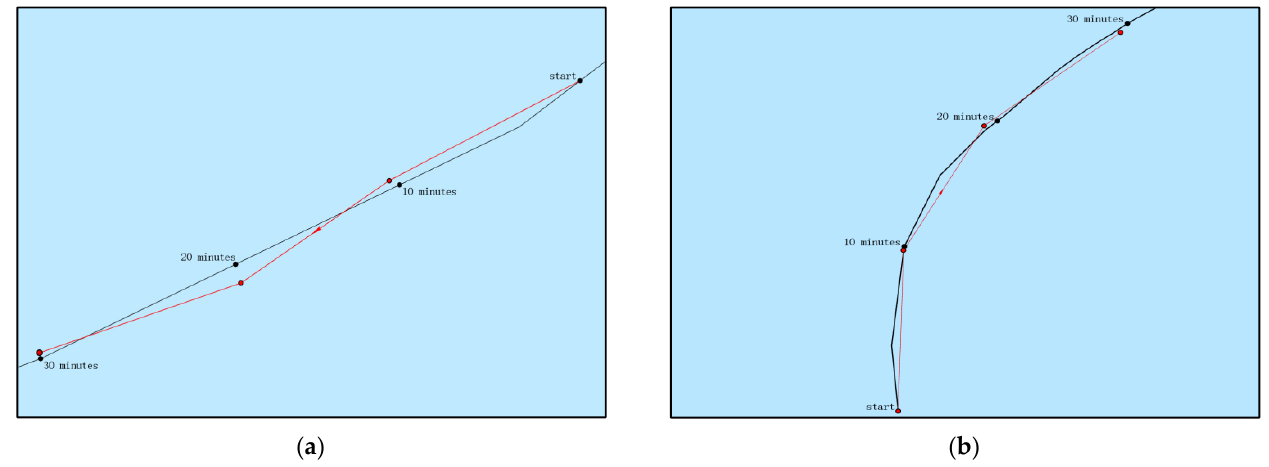
Figure 9. Comparison of actual points and predicted points with a 10 min prediction time interval. ( a ) Straight movement; ( b ) turning movement. Table 2. Example values of time duration, ActualLongitude, ActualLatitude, PredictedLongitude, and PredictedLatitude.